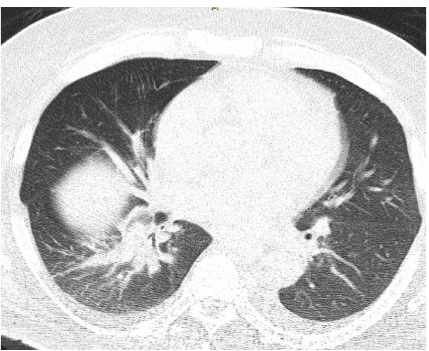
Figure 1: Axial image of CT of chest performed on August 17, 2013: pulmonary windows demonstrating atelectatic change or scarring in the right lower lobe.